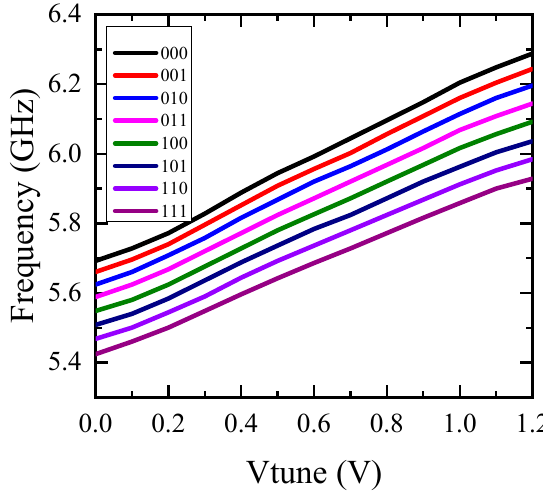
Figure 11. Measured VCO frequency tuning curves.